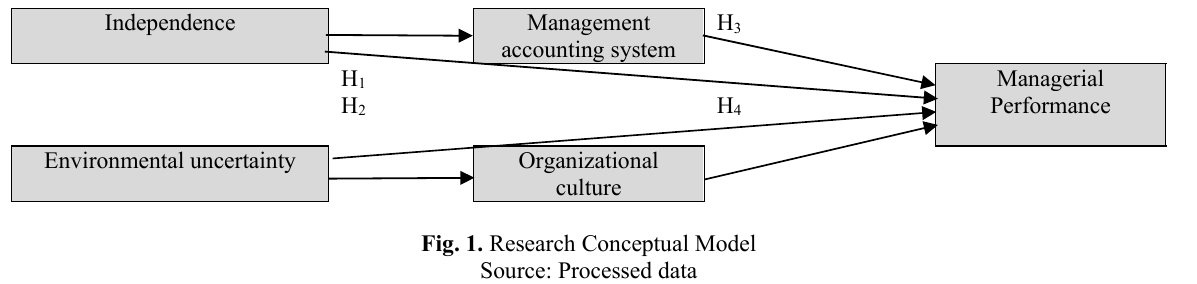
Fig. 1. Research Conceptual Model Source: Processed